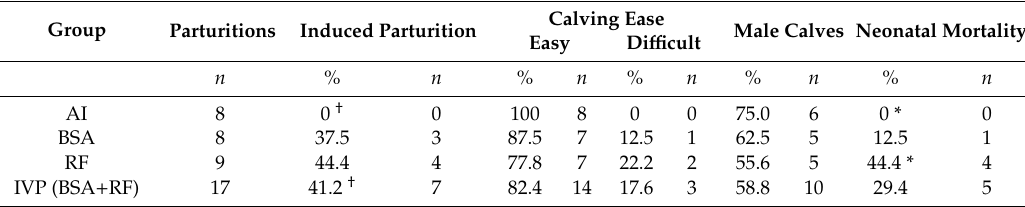
Table 4. Induced parturitions, calving ease score, male calves, and neonatal mortality within groups of artificial insemination (AI), bovine serum albumin (BSA), reproductive fluids (RF) or in vitro produced (IVP, corresponding of BSA + RF). Calving Ease